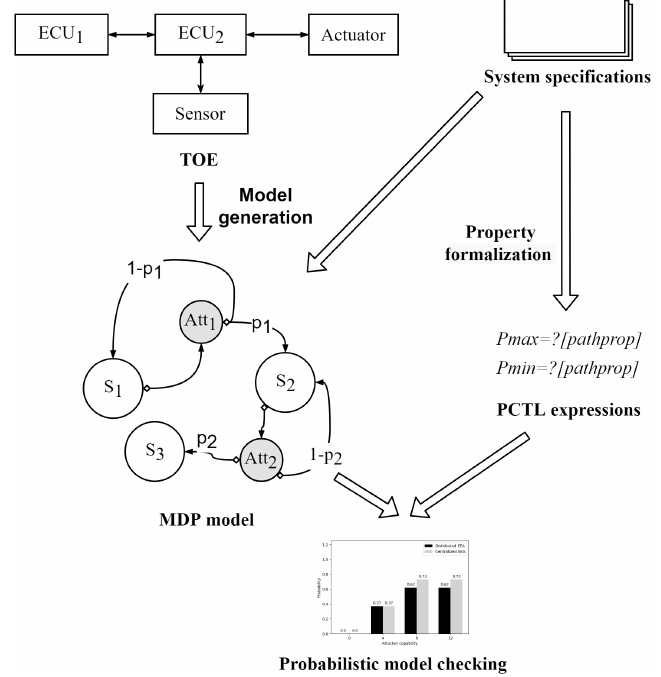
Figure 2. Security risk assessment framework for safety-critical systems of connected